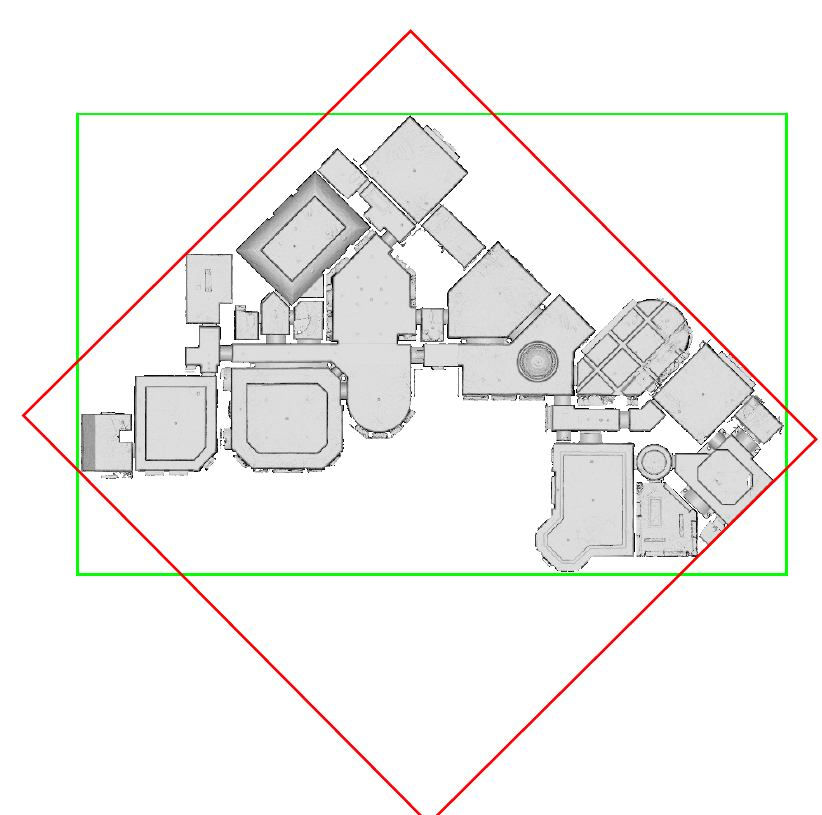
Figure 20. Resulting horizontal alignments of the triangle mesh “mJXqzFtmKg4” from Figure 15f for the two peaks in the histogram of δ h values depicted in Figure 18. The green bounding box corresponds to the peak at δ h ≈ 0° (i.e., the ground truth pose), while the red bounding box corresponds to the minor peak at δ h ≈ 45°.